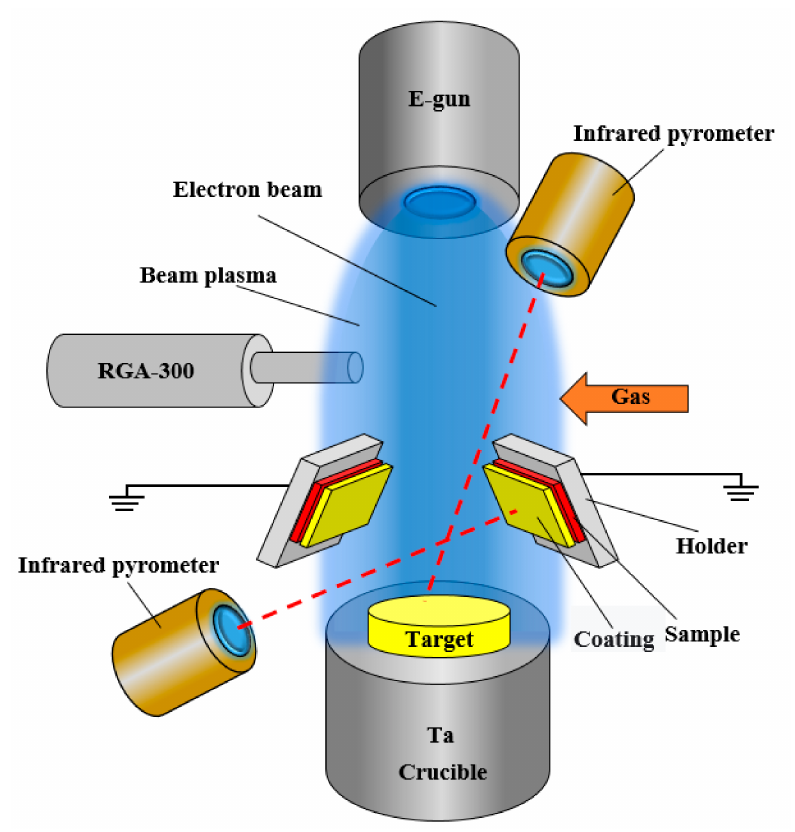
Figure 2. Schematic diagram of the coating deposition